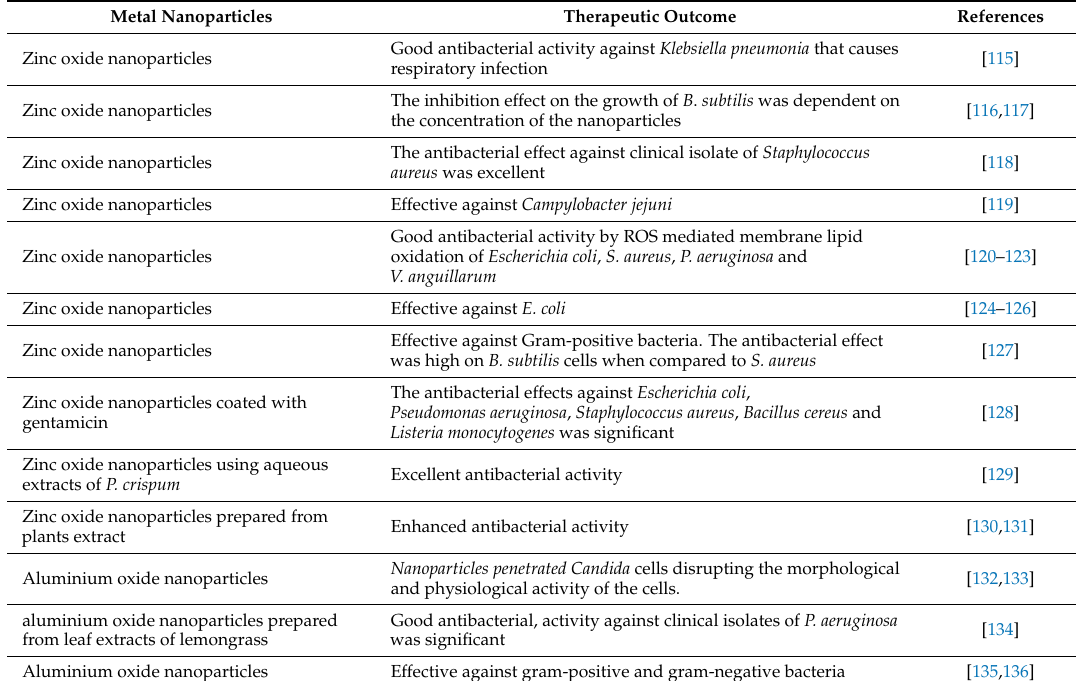
Table 3. Zinc oxide and aluminium oxide nanoparticles antibacterial